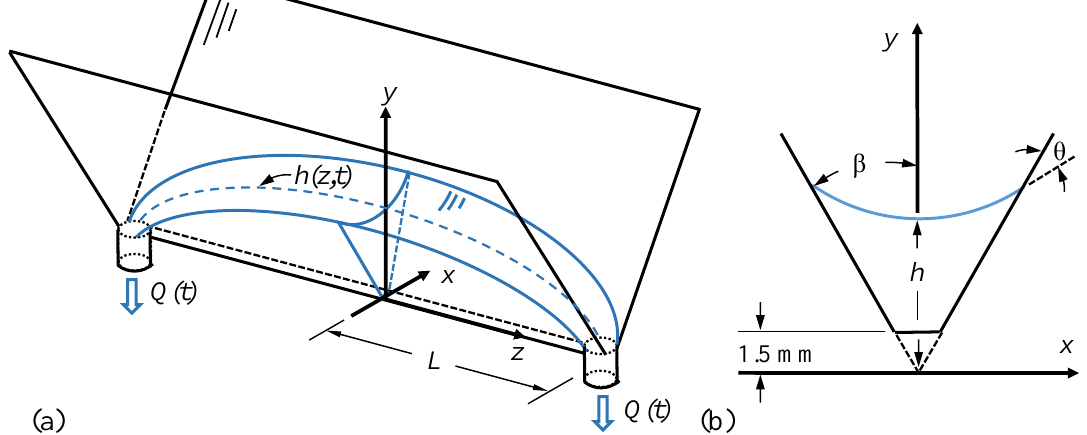
Figure 2. Schematic of double-drain flow analytical and computational domain. Drain ports are symmetric at z = ± L , where volumetric sink flow rates Q ( t ) are specified: ( a ) perspective view and ( b ) cross-sectional view, dashed end cropped from computational